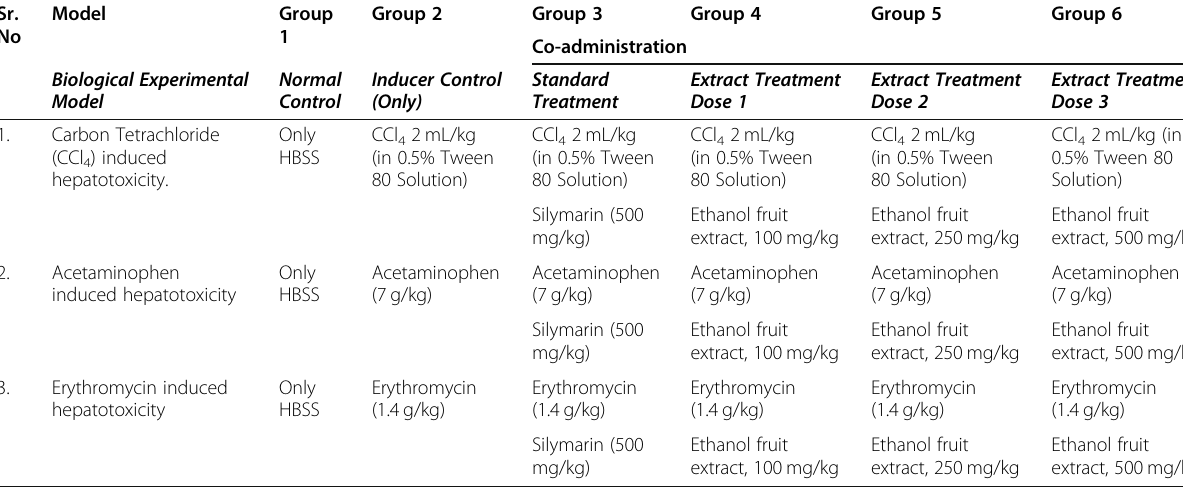
Table 3 Experimental Design/ Biological Models Sr.